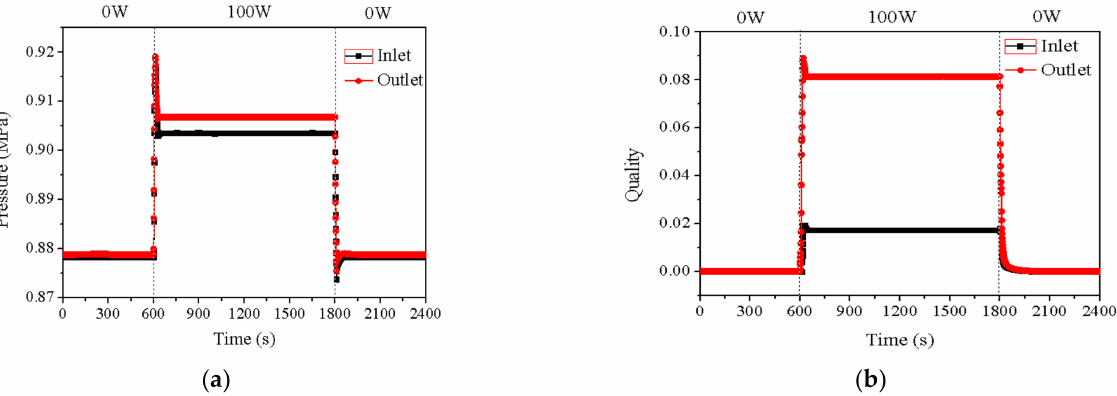
Figure 5. Temporal evolution of ( a ) pressure and ( b ) quality of the working fluid in the